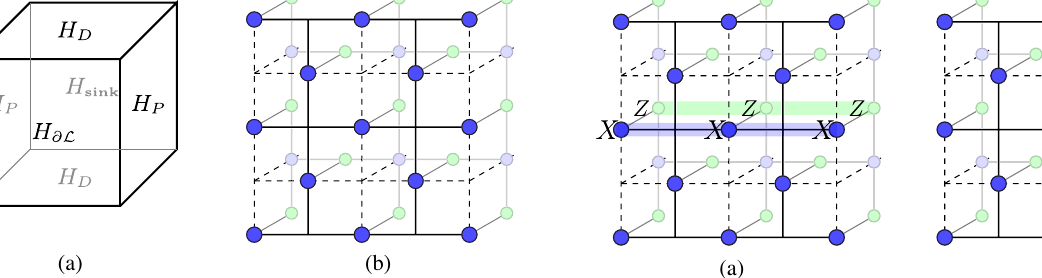
FIG. 11. Logical operators for the toric code boundary H ∂ L . ¯ X (a) Logical runs between the left and right smooth edges. ¯ Z (b) Logical runs between the top and bottom rough edges. Dashed lines denote edges of the cubic